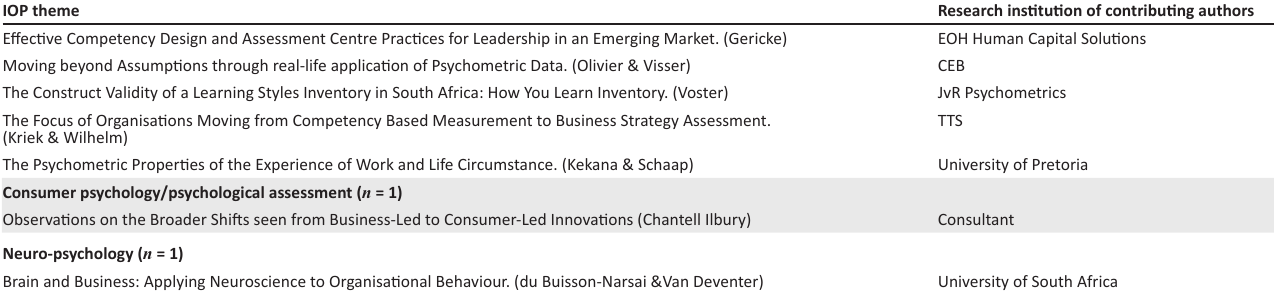
TABLE 2 (Continues...): Overview of SIOPSA’s 17th Annual Conference IOP paper presentation themes. IOP theme